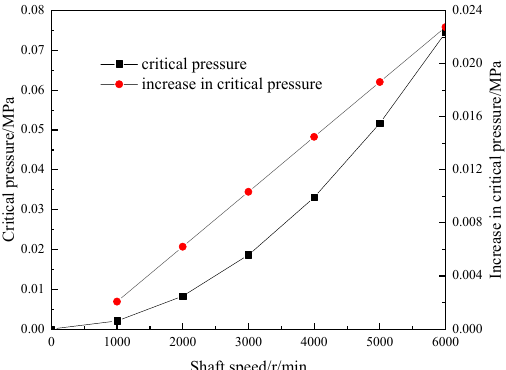
Figure 6. Theoretical critical pressure of the back blade seal.